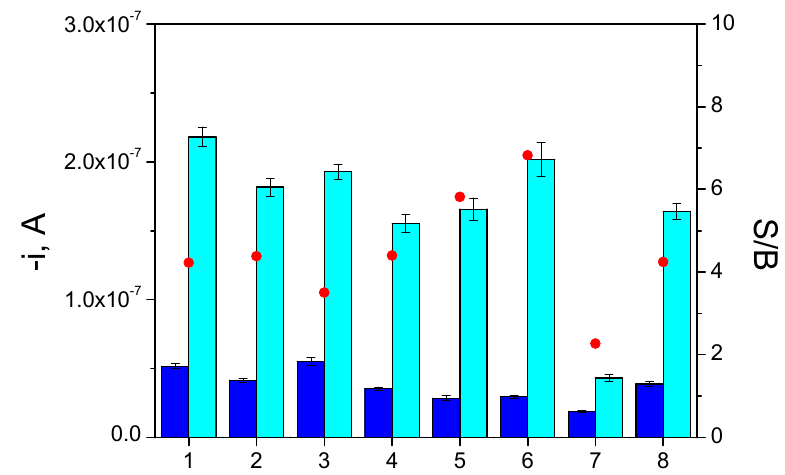
Figure 4. Immunosensor selectivity towards p53 protein. Current values measured for 0.0 (dark blue bars) and 10.0 (light blue bars) ng·mL − 1 human p53 standard in the absence (1) and in the presence of: 10.0 ng·mL − 1 TNF α (2); 5.0 ng·mL − 1 ErbB2 (3); 5.0 ng·mL − 1 ER α (4); 5.0 ng·mL − 1 PR (5); 5.0 mg·mL − 1 BSA (6); 1.0 mg·mL − 1 human IgG (7) and 0.1 mg·mL − 1 human IgG (8). Supporting electrolyte, 0.05 M sodium phosphate solution, pH 6.0; E app = − 0.20 V vs. the Ag pseudo-reference electrode. Other conditions are as described in Table 1 (selected values column). S/B ratio (red • ) are those obtained for each experimental point. Error bars estimated as triple that of the standard deviation ( n = 3).